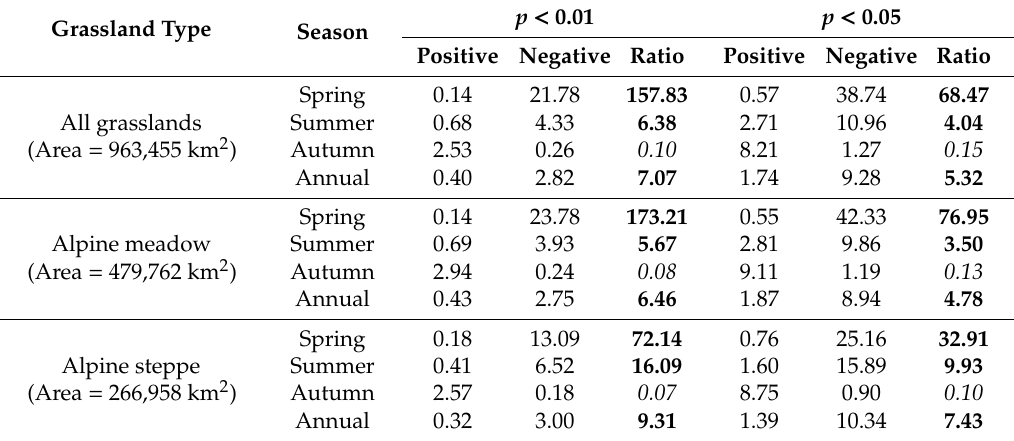
Table 2. Areal percentage of significant correlations between beginning of growing season (BGS) and seasonal or annual net primary productivity (NPP), and the ratio of negative correlated area to positive correlated area in di ff erent grassland types. Ratio values in bold and in italics indicate ratio of negative correlated area to positive correlated area > 2.0 and < 0.5, respectively.